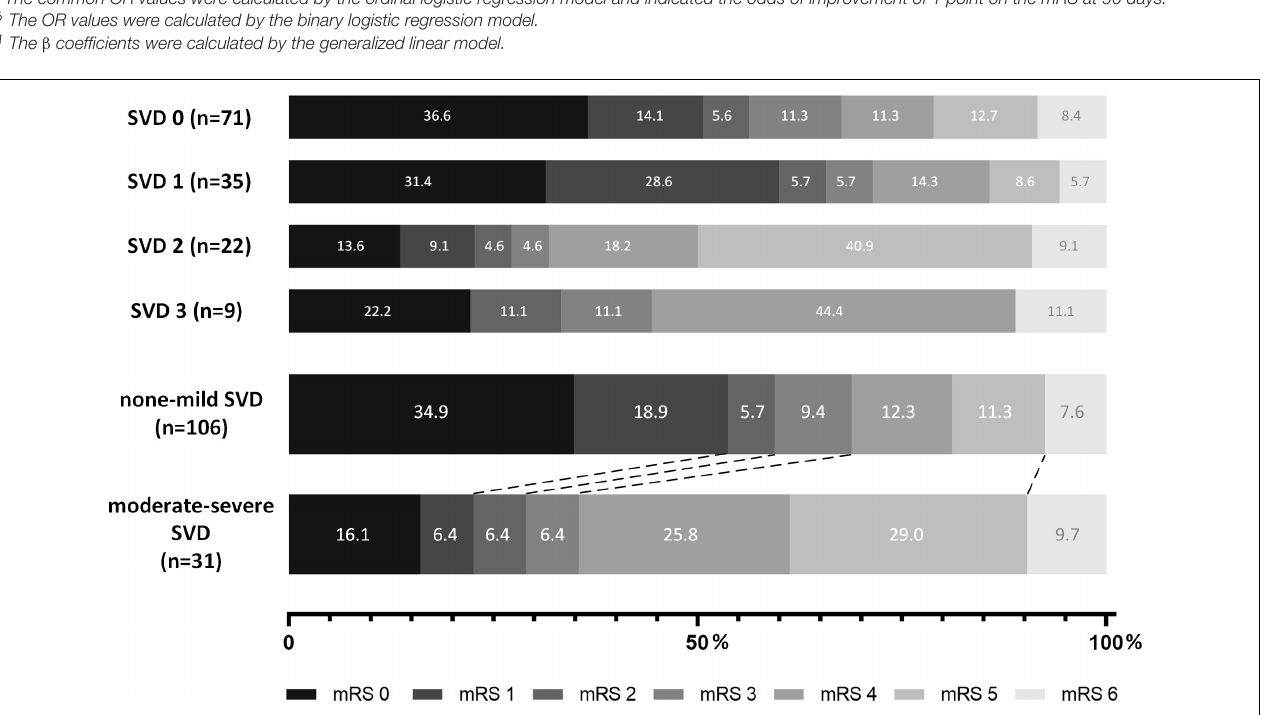
FIGURE 2 | Shift of 90-day modified Rankin Scale (mRS) score of patients with different SVD scores and